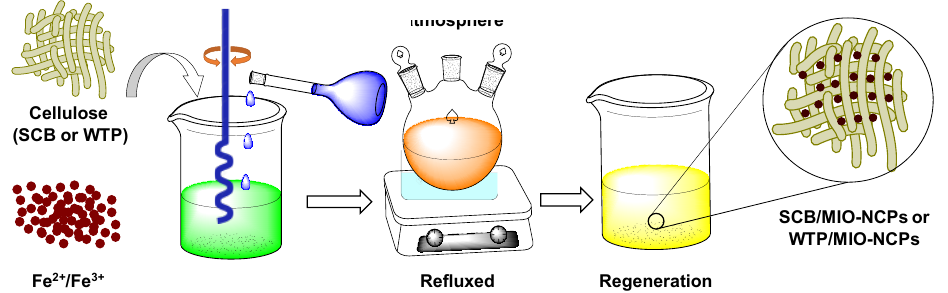
Figure 3. Overall preparation protocols of WTP/MIO-NCPs and SCB/MIO-NCPs.